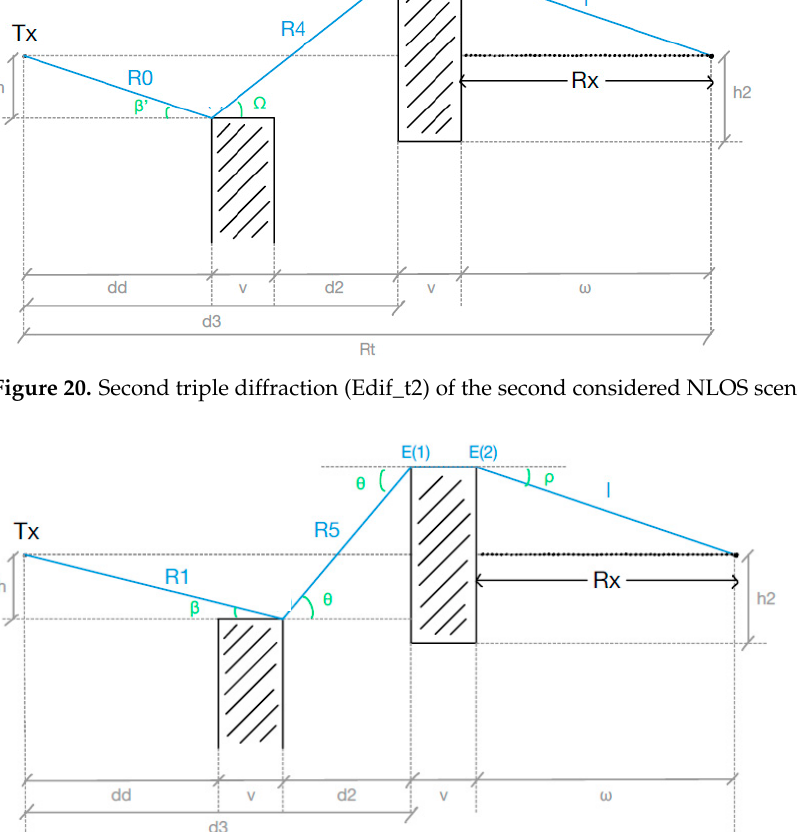
Figure 20. Second triple diffraction (Edif_t2) of the second considered NLOS scenario. Figure 21. Third triple diffraction (Edif_t3) of the second considered NLOS Figure 21. Third triple diffraction (Edif_t3) of the second considered NLOS scenario.